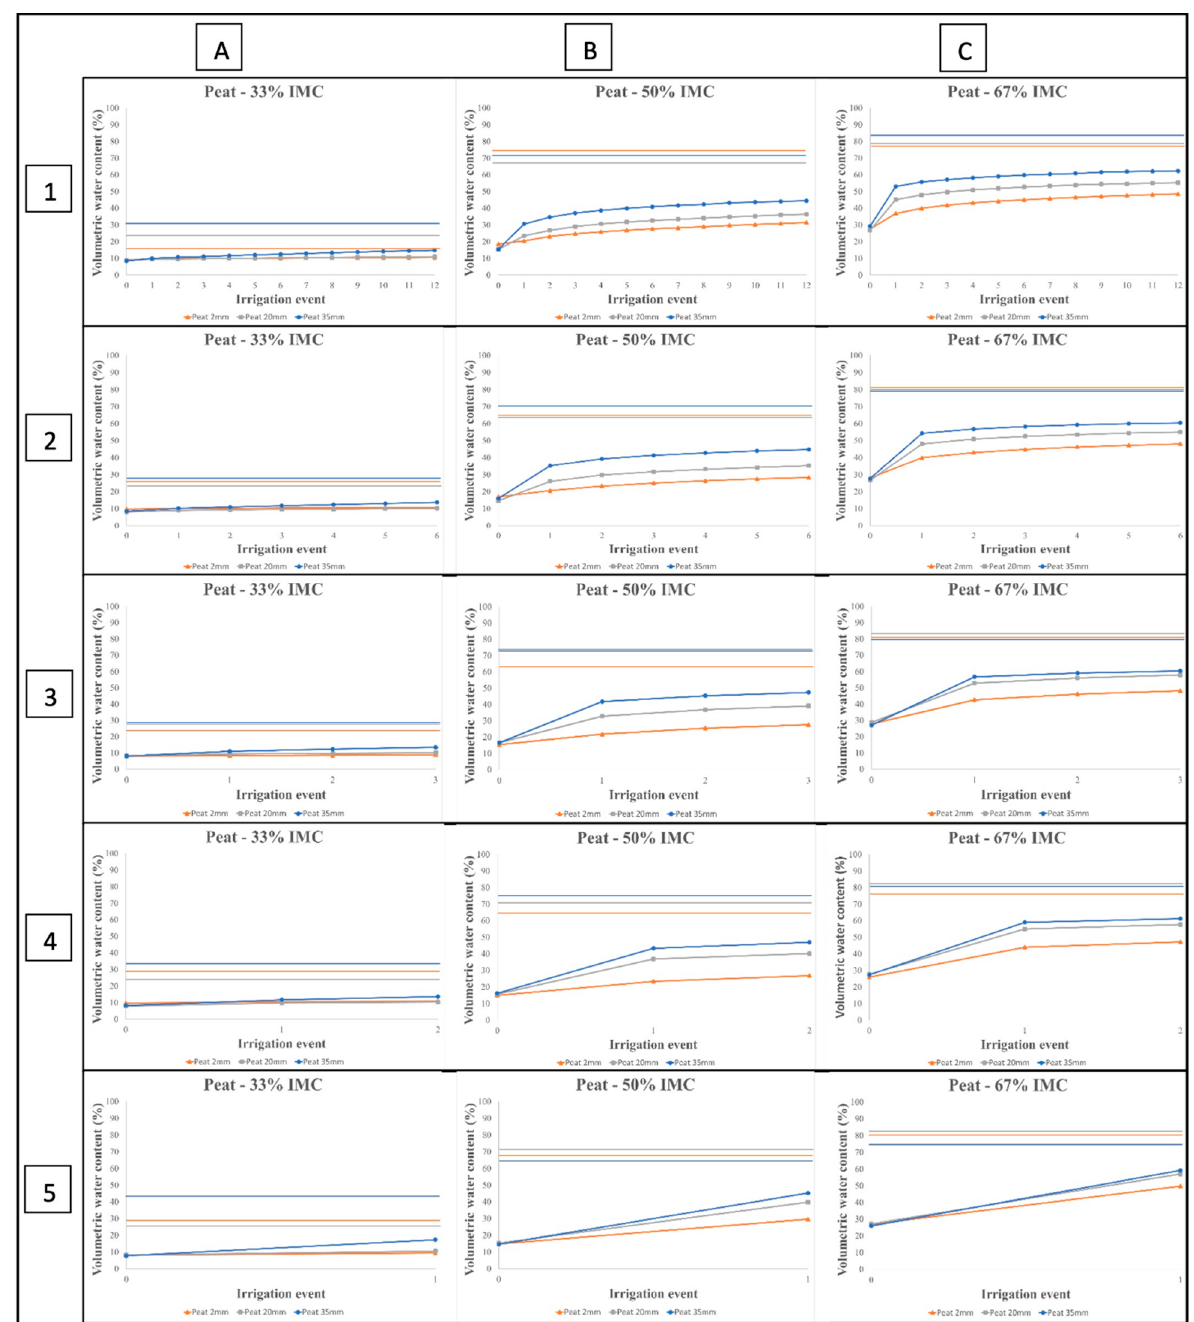
Figure 3. Substrate water capture volumetric water content curves for peat over three initial moisture contents (IMC) of ( A ) 33%, ( B ) 50%, and ( C ) 67%, three irrigation water levels of 2 mm (orange), 20 mm (gray), and 35 mm (blue), and at five irrigation pulse durations of 5 min (1), 10 min (2), 20 min (3), 30 min (4), and 60 min (5). The container capacity for each water level is denoted by the color matched solid bar on the figure.